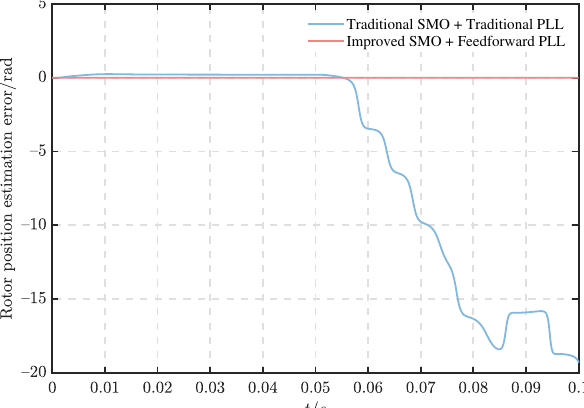
Figure 18. Rotor position observation errors (forward and